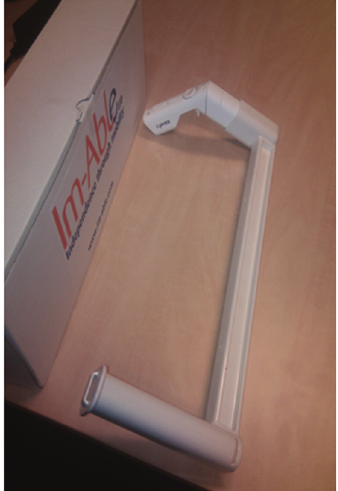
Figure 6: Able-X with CyWee Z. Reprinted with